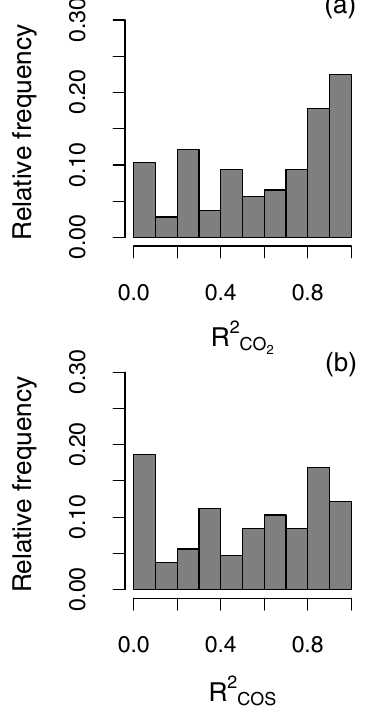
Figure 3. Relative frequency of R 2 values of the correlation be- tween concentrations of 222 Rn and CO 2 (a) and COS (b)